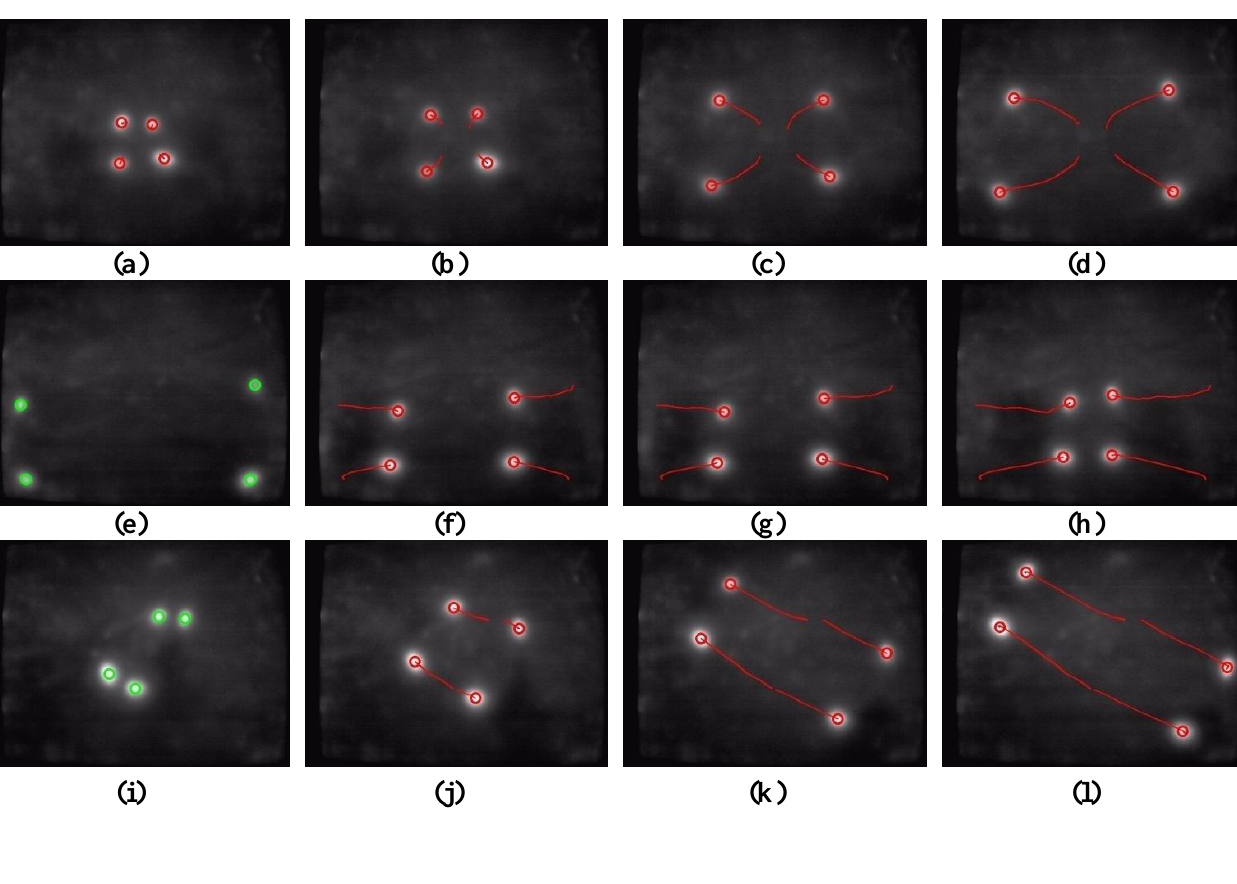
Figure 13. Touch finger detection and tracking results of the proposed system in Test sequence 3. (a) 33 rd frame. (b) 35 th frame. (c) 38 th frame. (d) 41 st frame. (e) 152 nd